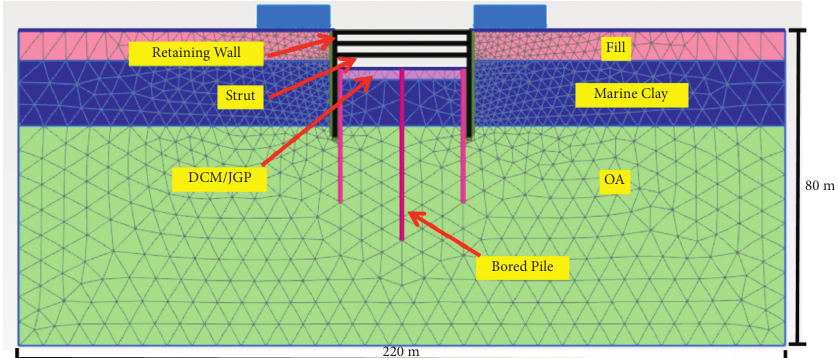
Figure 2: FEM mesh used in PLAXIS analysis.